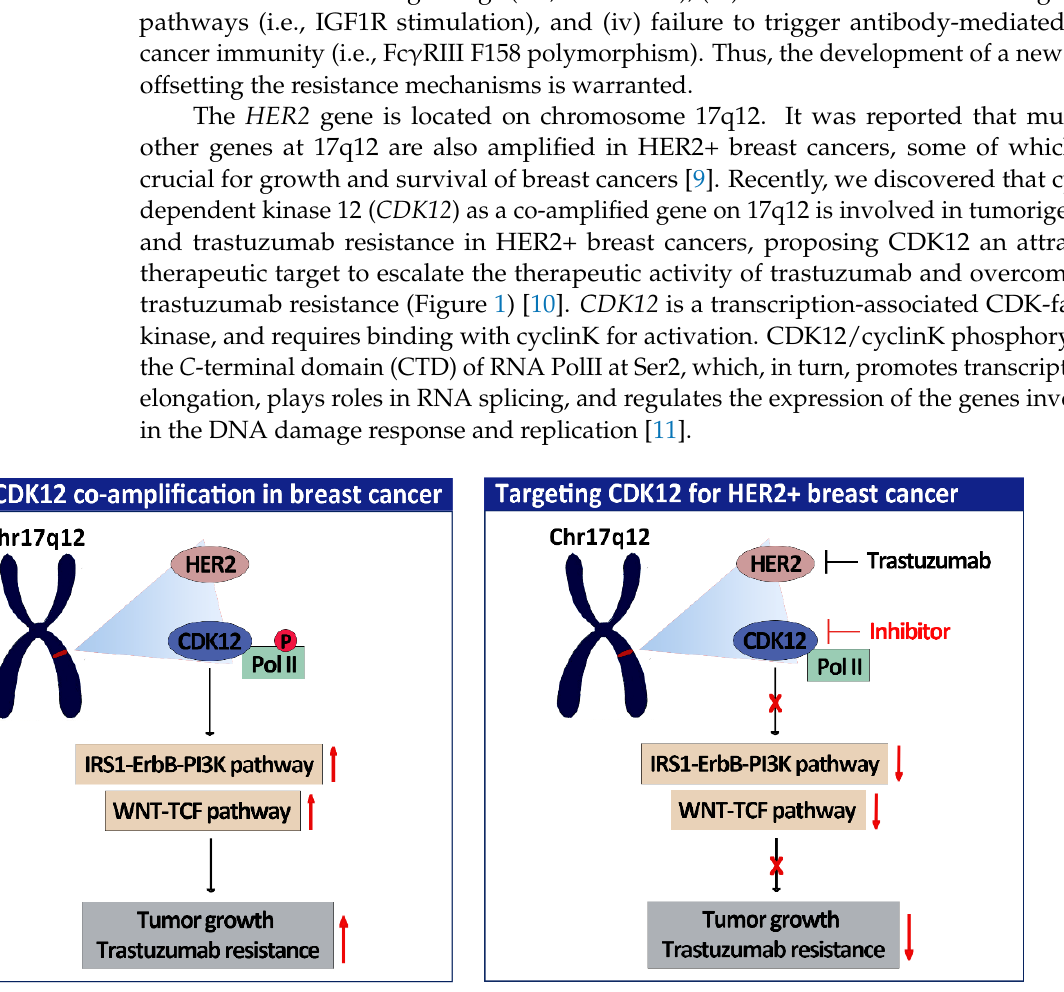
Figure 1. CDK12 is an attractive therapeutic target for HER2+ breast cancers. CDK12 and HER2 are co-amplified on chromosome 17q12 in HER2+ breast-cancer patients and involved in tumor growth and trastuzumab resistance through upregulation of IRS1-ErbB-PI3K and WNT-TCF pathways. Several CDK12 inhibitors and their anti-cancer activities have been reported (Figure 2)